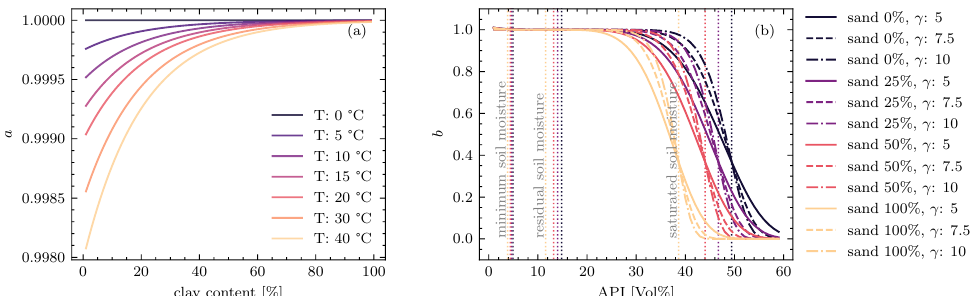
Figure 2. Soil moisture loss factors a , depending on clay content and temperature ( a ) and b depending on sand content and saturation state ( b ) for the applied α and γ